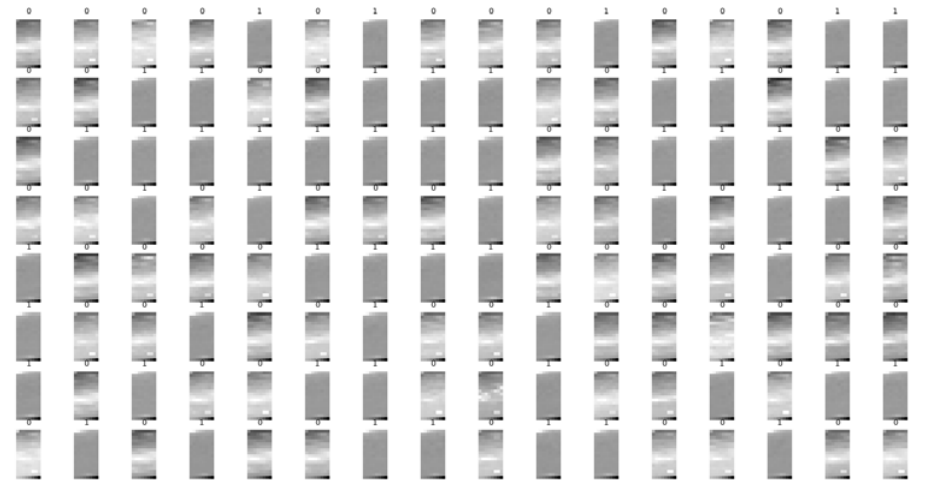
Figure 4. Signal characteristic spectrogram.